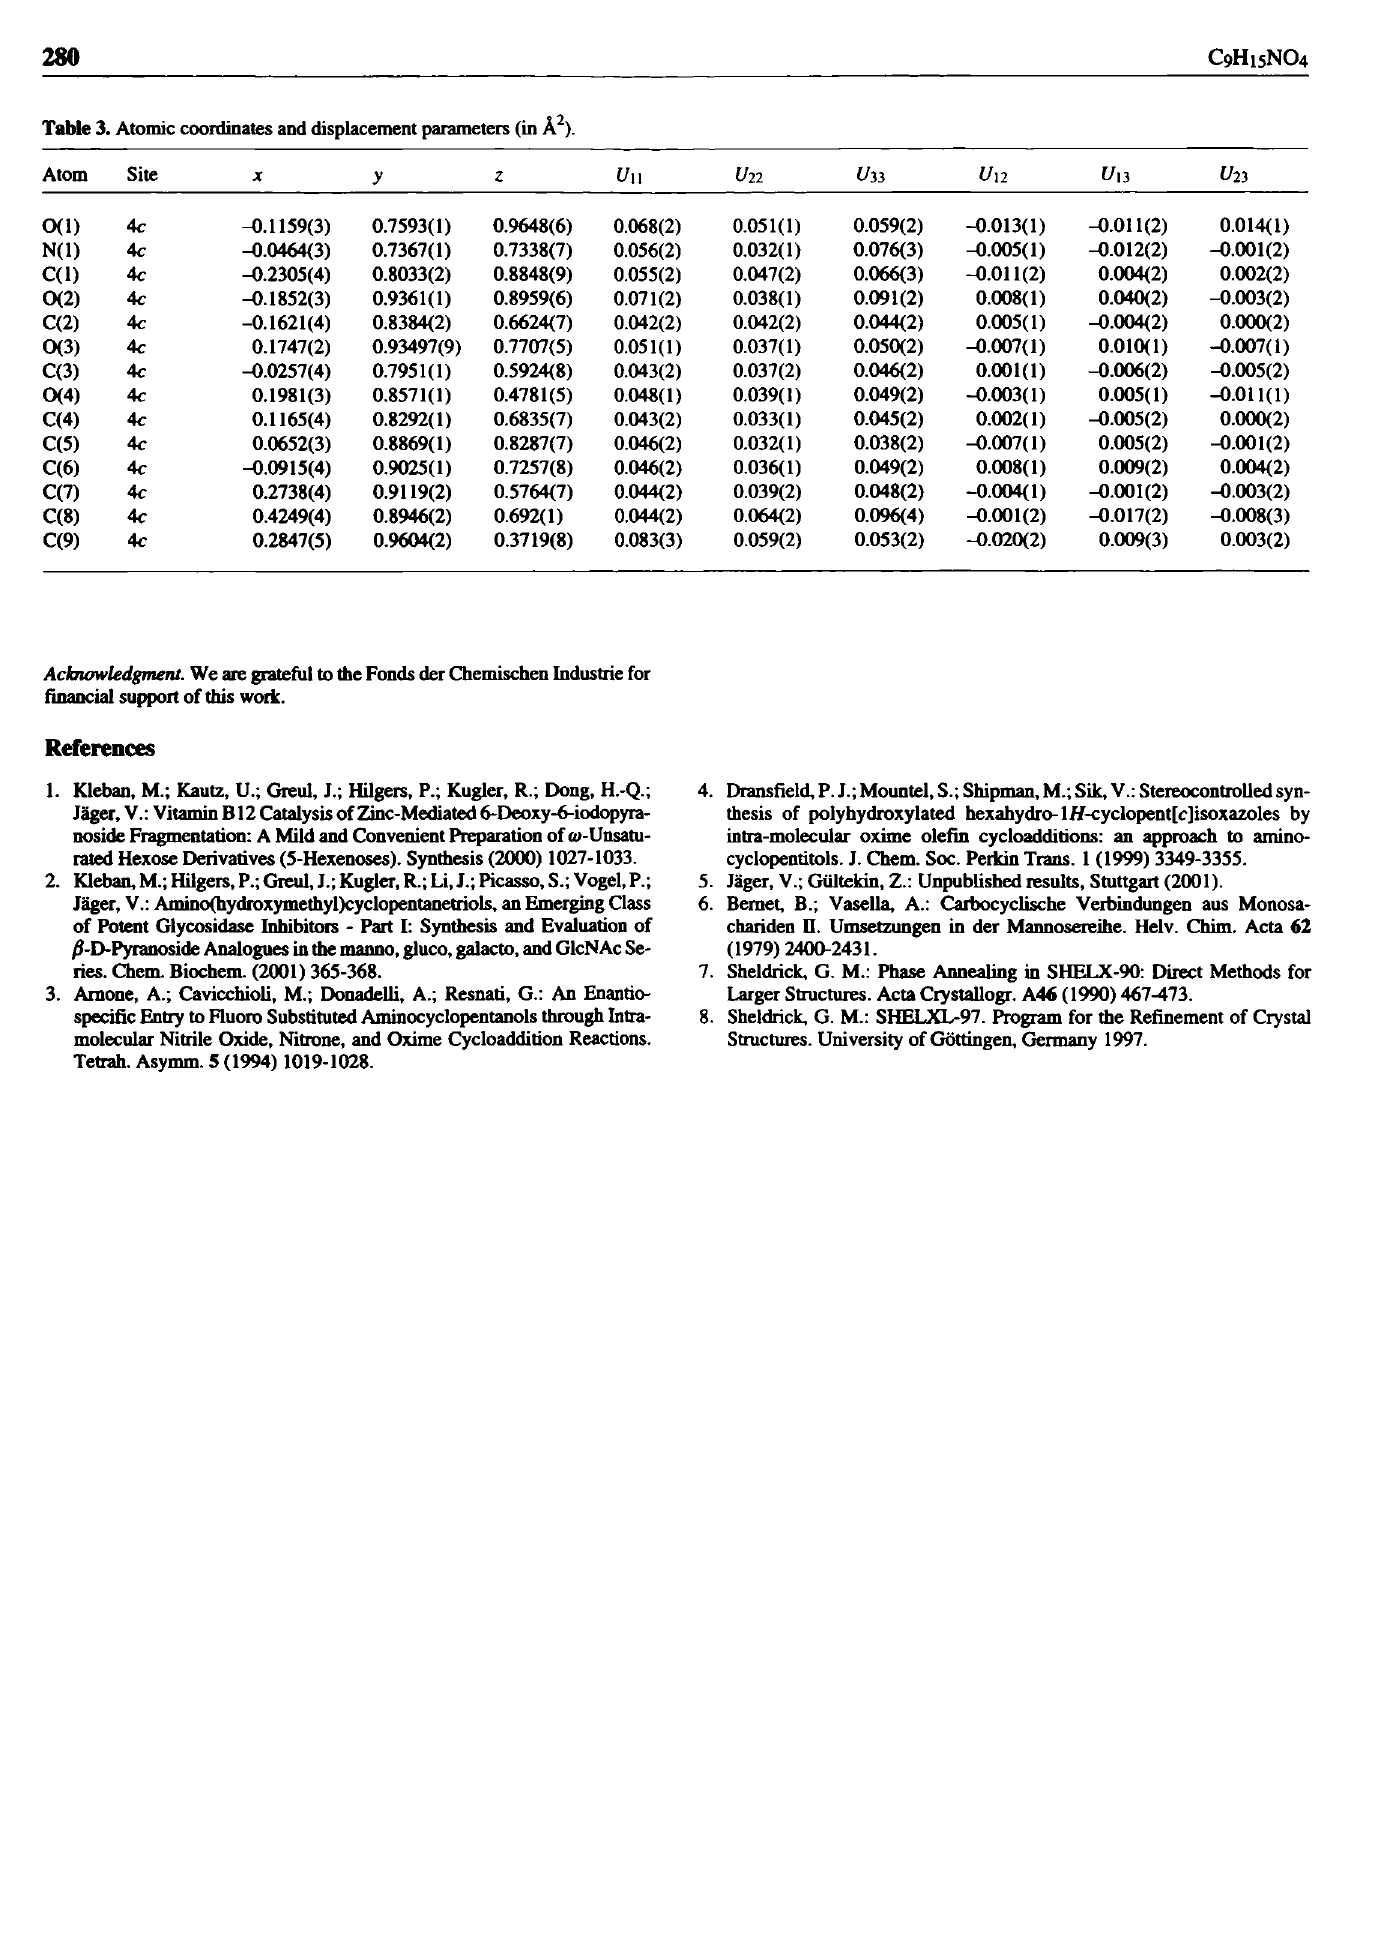
Table 3. Atomic coordinates and displacement parameters (in Â 2